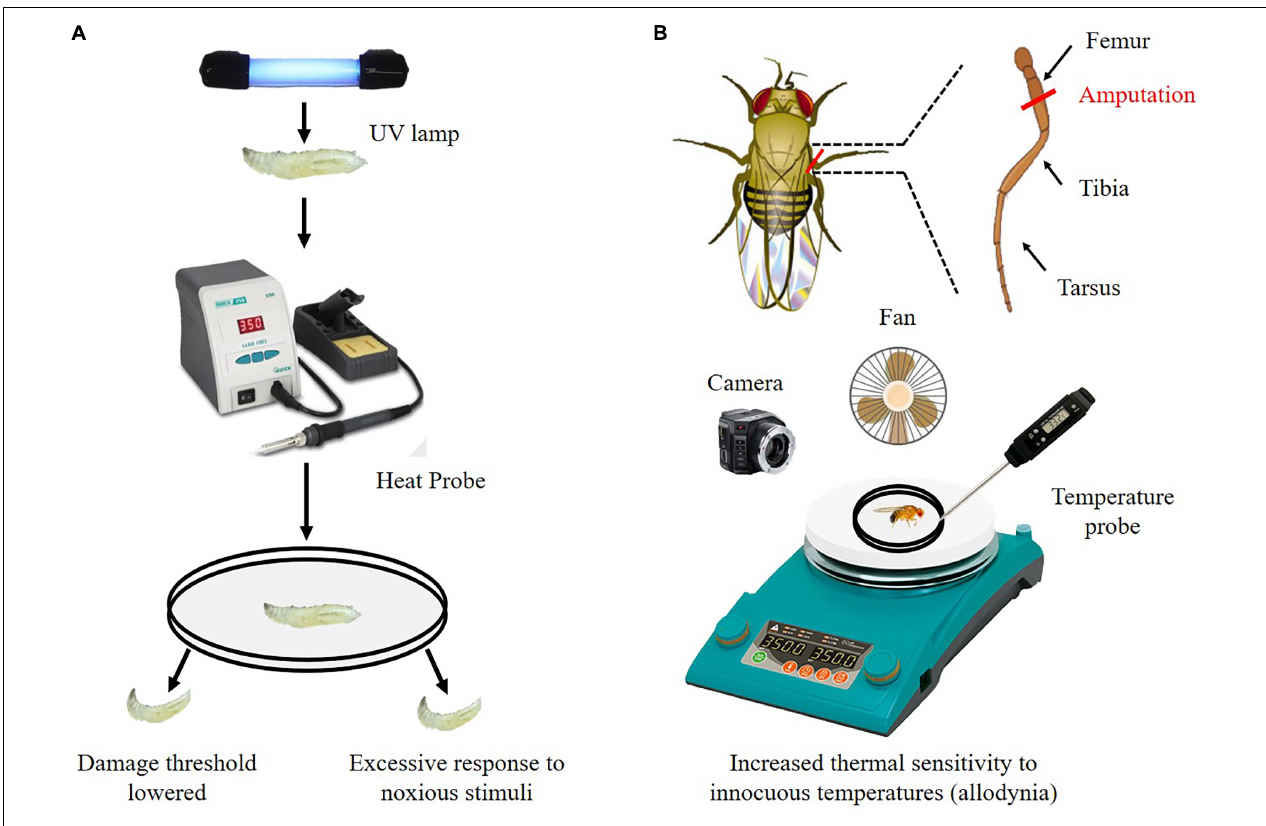
FIGURE 3 | Detection method of chronic pain perception in flies. (A) Drosophila larvae have a reduced nociceptive temperature threshold and overreact to noxious temperature stimuli after exposure to UV light. (B) After amputation, adult flies were subjected to thermal stimulation. Adult flies have increased thermal sensitivity to innocuous temperatures